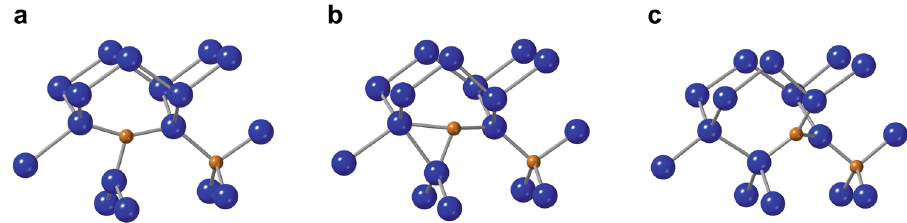
Fig.2|PathfortheformationoftheA - con fi gurationupontheencounterofadiffusing(C-Si) Si splitinterstitialandaC Si substitutional.a initialstate, b (near-)saddle- point con fi guration (c.f. Fig. 4), and c end state of the MEP calculation.